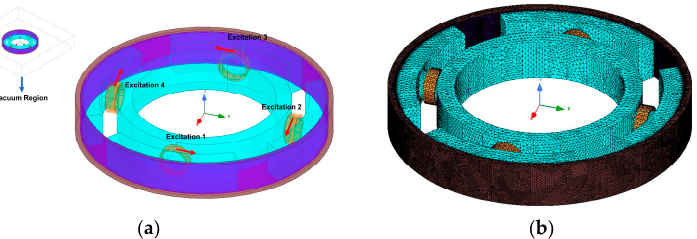
Figure 12. Magnetic field analysis simulation setup of circumferential configuration: ( a ) excitation and boundary settings; ( b ) finite element meshing.